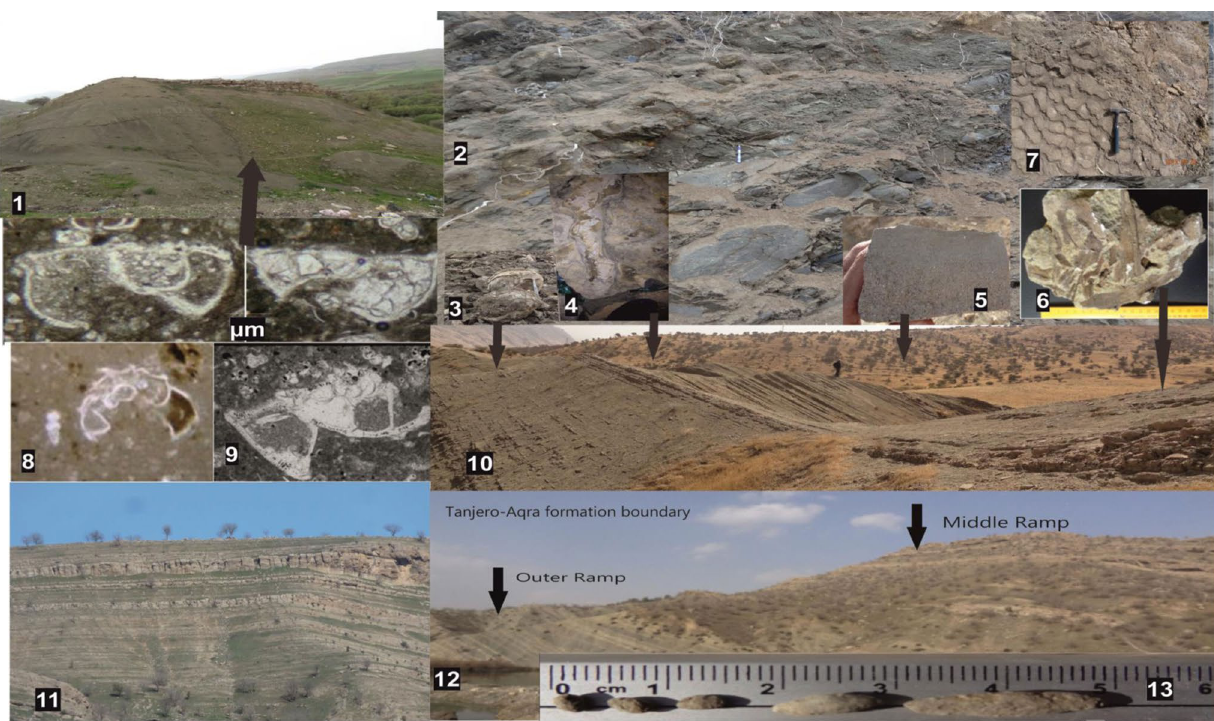
Fig. 5 1. Planktonic mudstone, within lower part of Tanjero fn. 2. Proximal turbidite facies associations, with thickened and coarser siliciclastics. 3. Ball and pillow structures. 4. Planolites ichnofossils. 5. Graded bedding turbidites. 6. Plant remains. 7. Ripple marks. 8 and 9. Planktonic foraminiferal facies within middle part Tanjero forma-